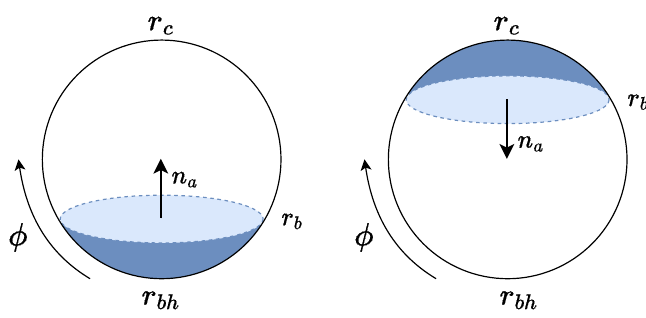
Figure 1 . The Euclidean Nariai geometry is an S 2 . The choice of sign of the outward pointing normal vector is dependent on which horizon we choose to integrate from. The direction of increasing φ is indicated which we will always take to increase from the back hole horizon towards the cosmological horizon.